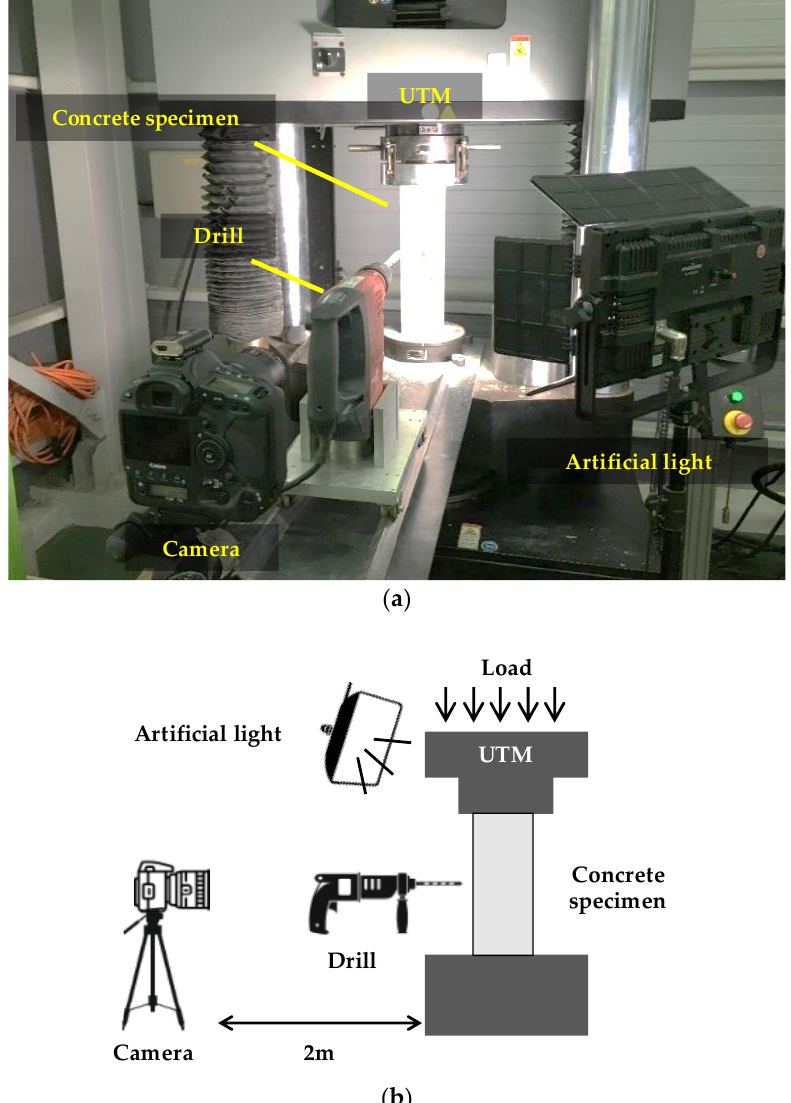
Figure 2. Laboratory-scale experiment: ( a ) Experimental setup; ( b ) Schematic view.